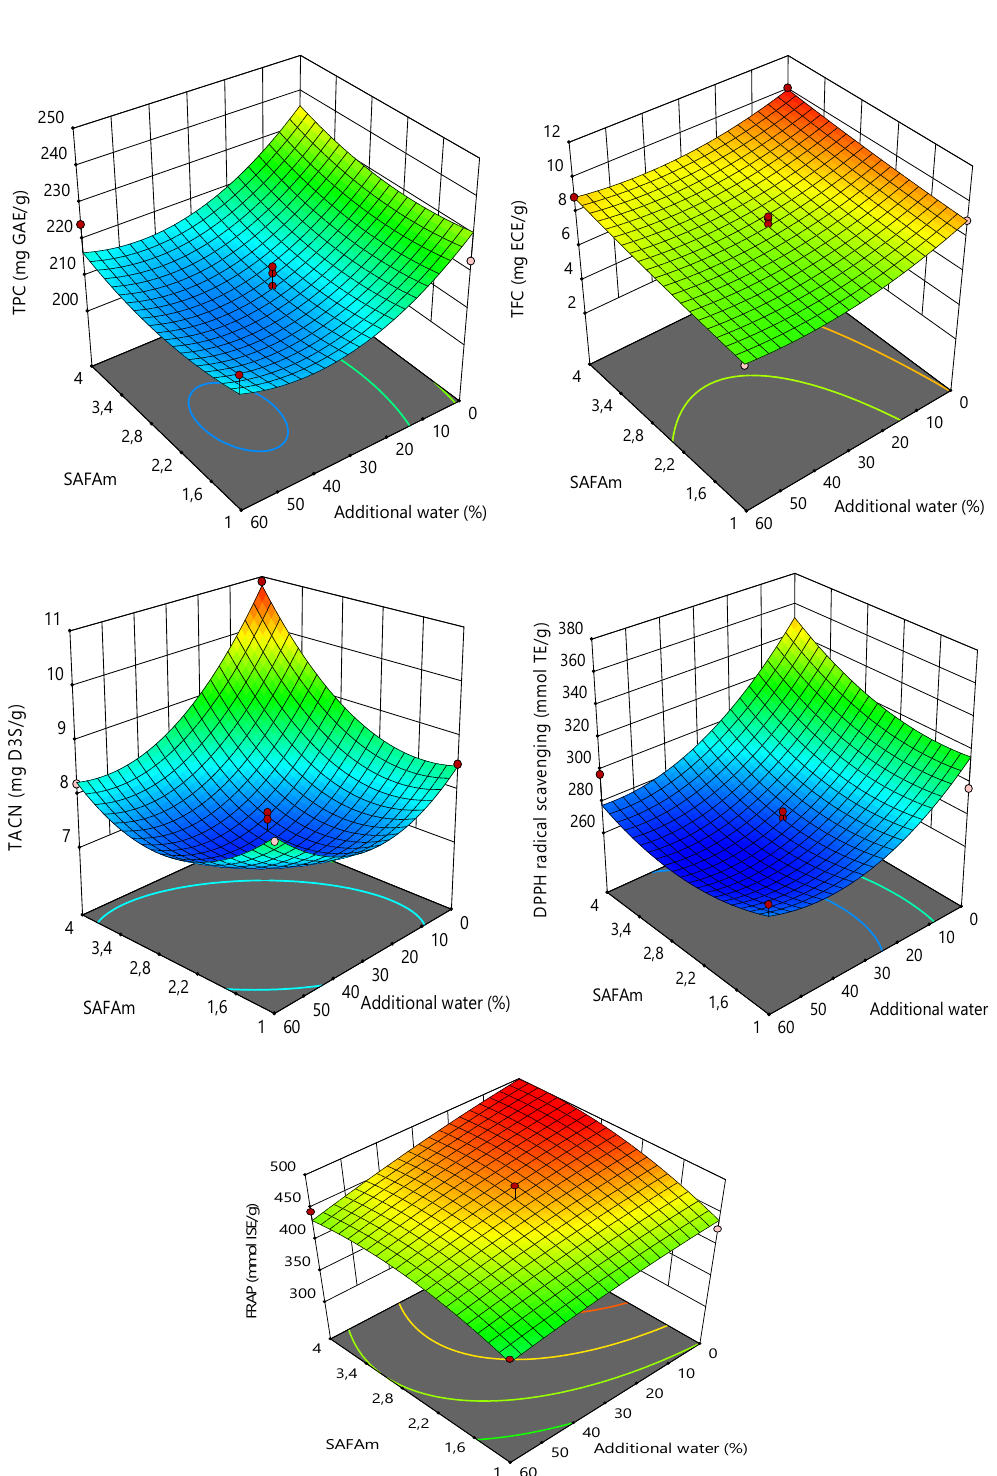
Figure 2. 3D response surface plots showing the effect of independent variables on the responses.